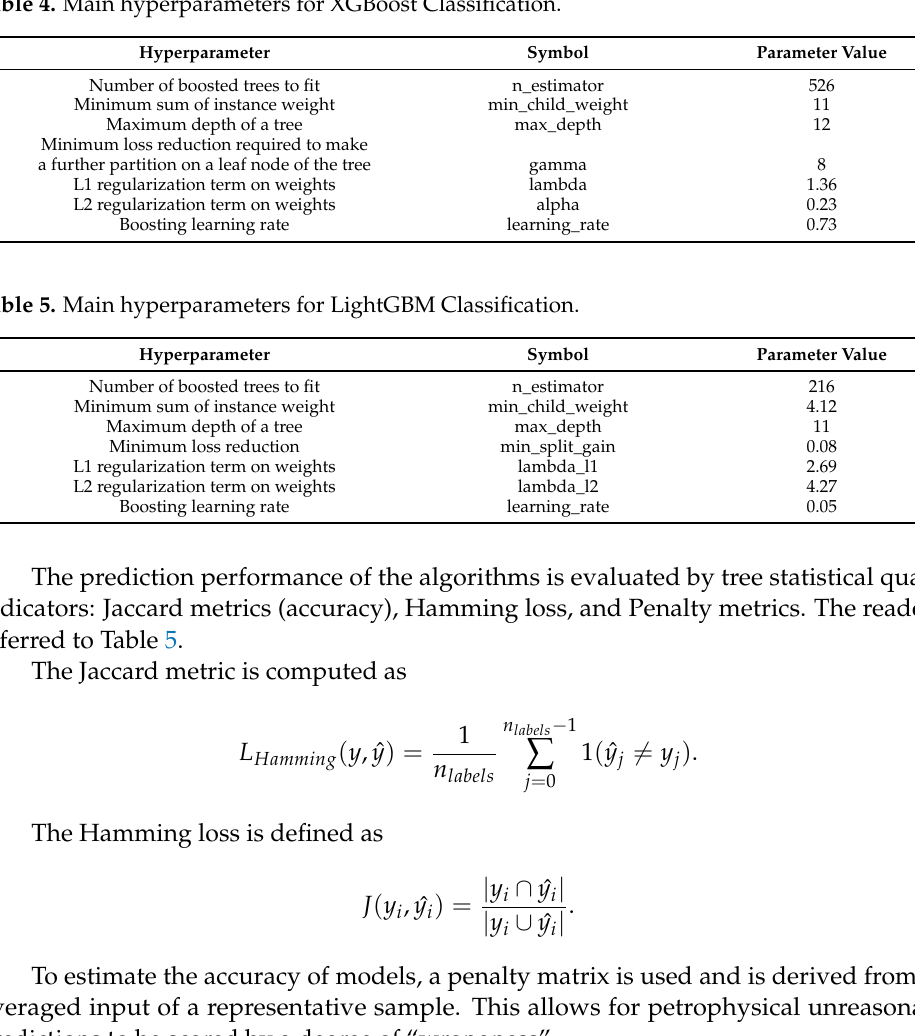
Table 4. Main hyperparameters for XGBoost Classification.